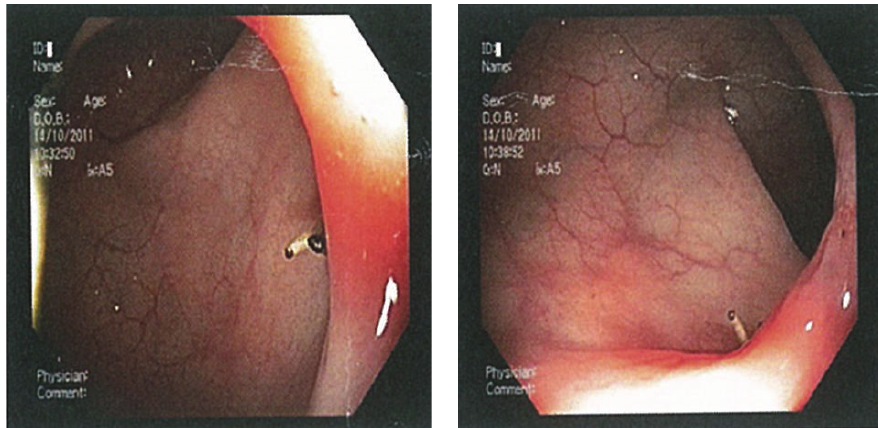
Figure 2: Colonoscopic view of the copper-T device partially penetrated to sigmoid colonic